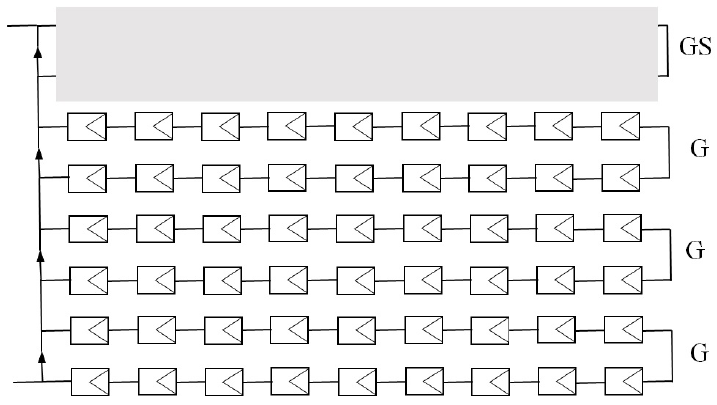
Figure 13. Shadow affecting 25% of the adopted panel area.